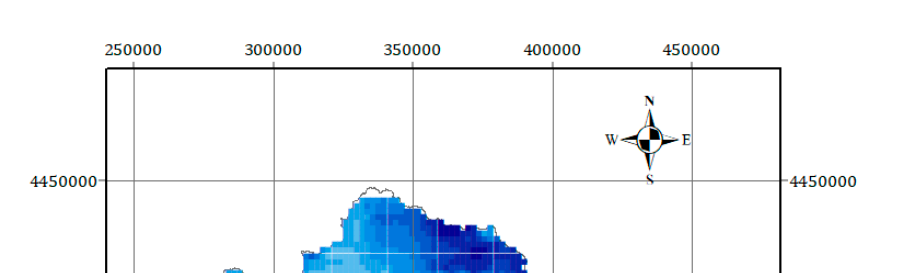
Table 2. Ombrian parameters α , η , ξ , β of Equations (6) and (12). Parameter λ is analytically derived at any point in space through the BSSE model.